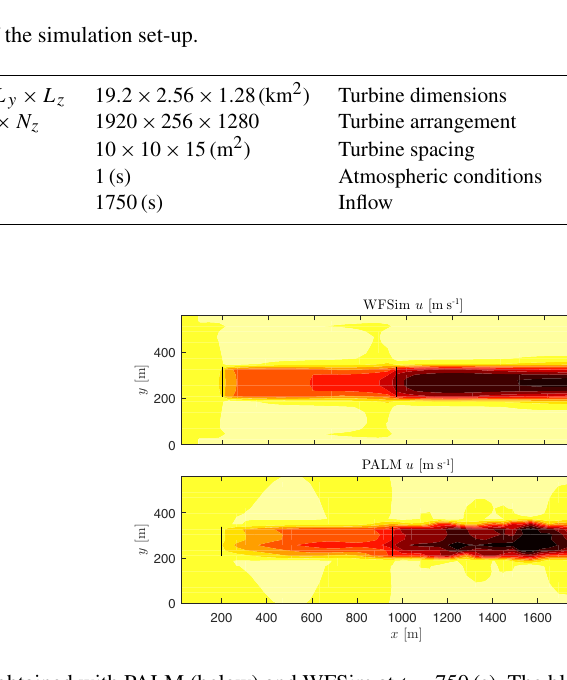
Wind Energ. Sci., 3, 75–95,